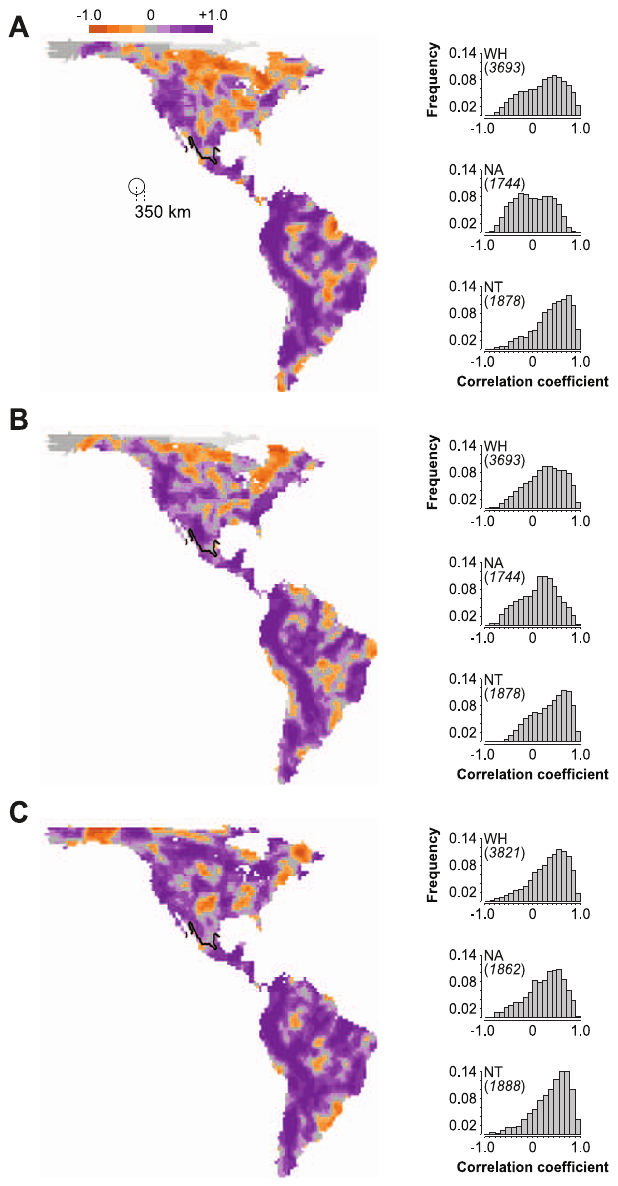
Figure 3. Geographic Variation in Beta-Diversity Congruence of Amphibians, Birds, and Mammals at Small Spatial Extents The color of each grid cell indicates the strength of beta-diversity ( b sim-d ) congruence calculated within a 350-km-radius window around that grid cell. Orange shades represent strong (darkest) to weak (lightest) negative correlations. Purple shades show strong (darkest) to weak (lightest) positive correlations. Dark gray indicates very weak correlations of either sign, or no correlation. Light gray grid cells do not contain amphibian species. Shown to the right of each map are frequency distributions of correlation coefficients for windows located within the entire Western Hemisphere (WH), the Nearctic realm (NA), and the Neotropical realm (NT), which are consistent with the overall level of congruence measured at these extents. The black line marks the boundary between the two realms. (A) Amphibians and birds. (B) Amphibians and mammals. (C) Birds and mammals.